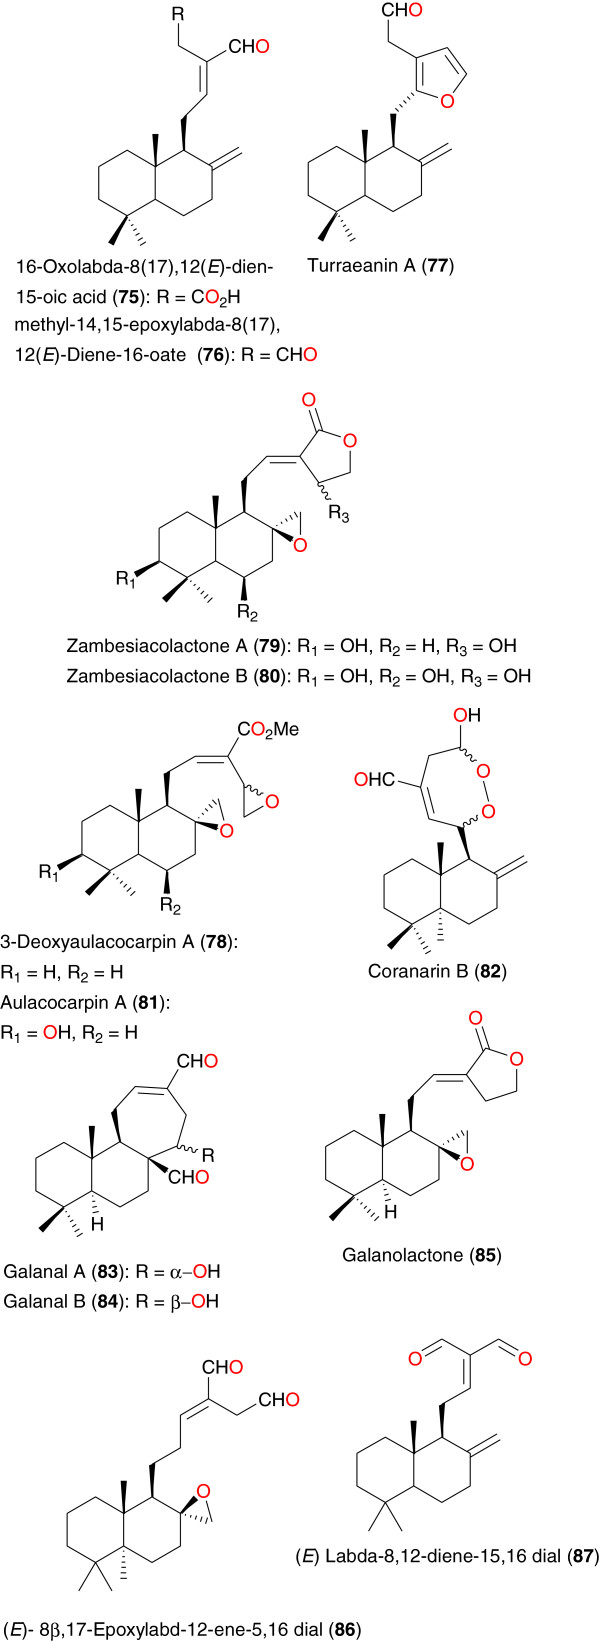
Clerodane and labdane diterpenoids from African medicinal plants with anti-malarial activity – II.